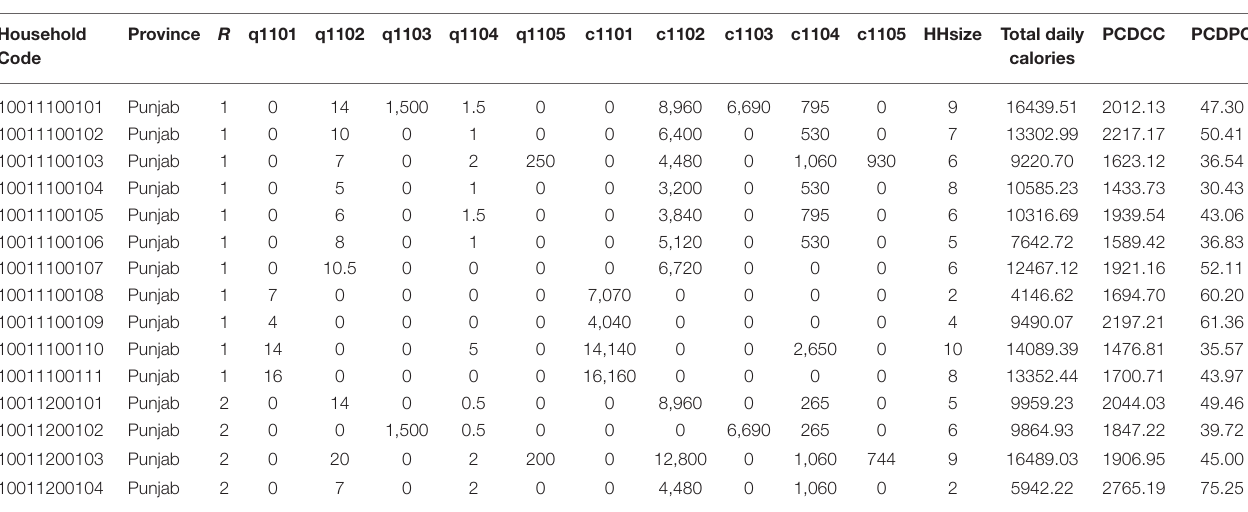
TABLE 2 | Computational details of household nutrient